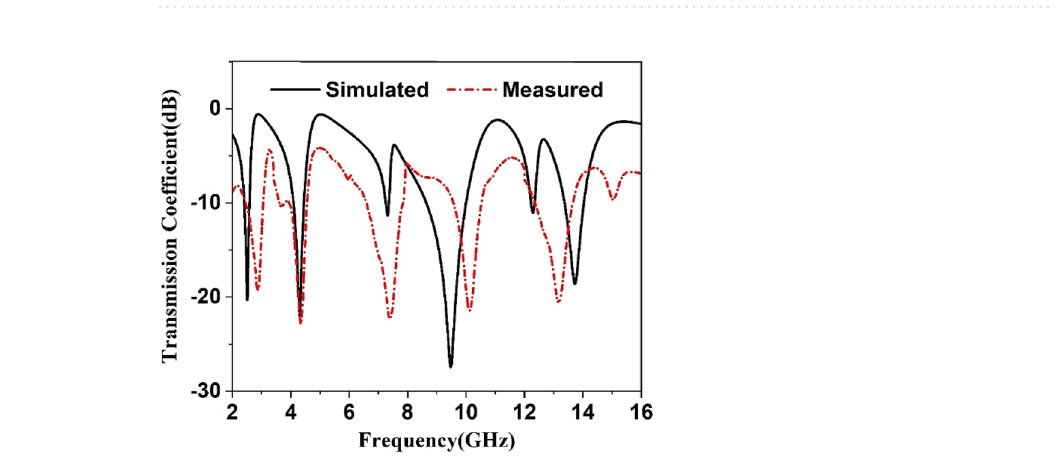
Figure 21. The measured transmission coefficient of the proposed MTM unit